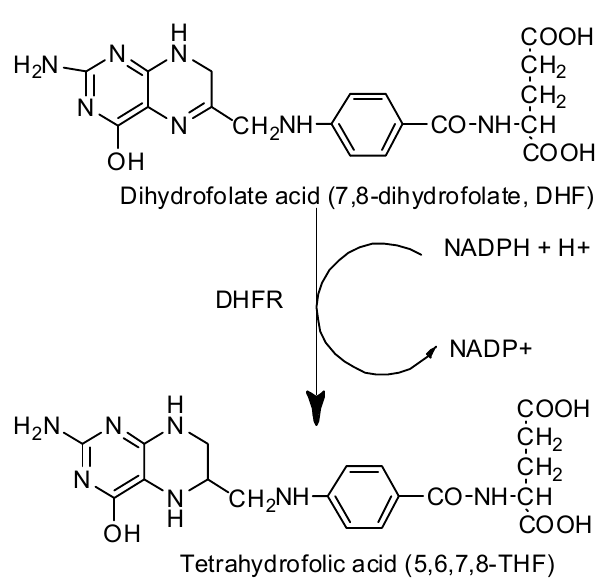
Scheme 1. Distinct step in folate metabolism: tetrahydrofolate synthesis pathway